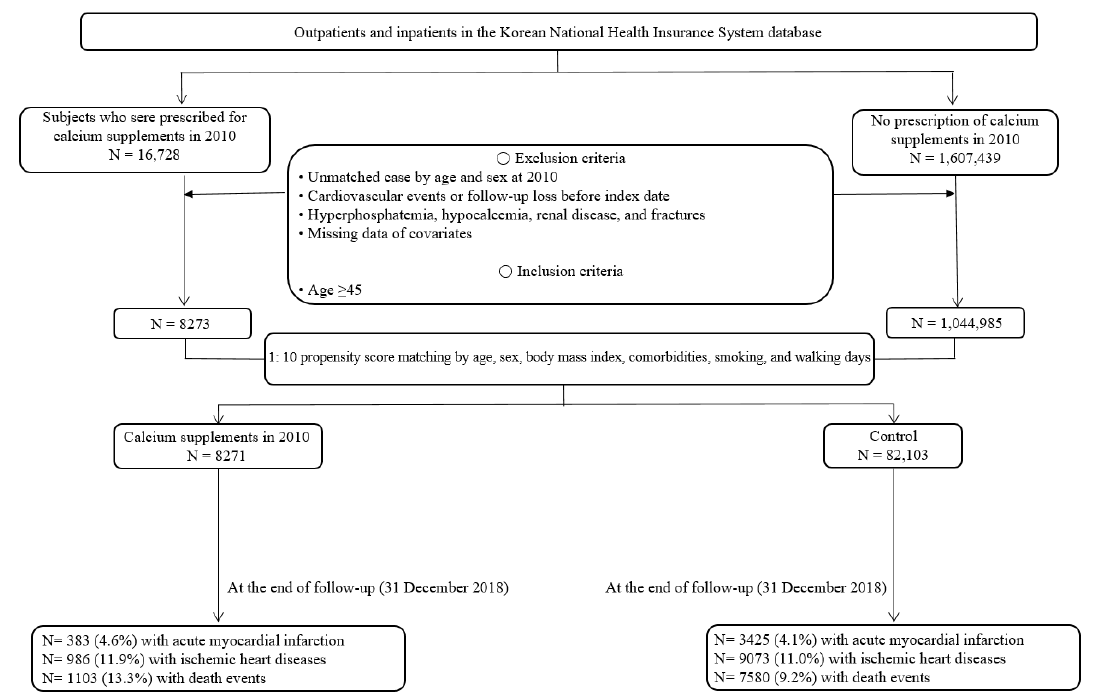
Figure 1. Flowchart of participant selection from the National Health Insurance Service database of Korea.